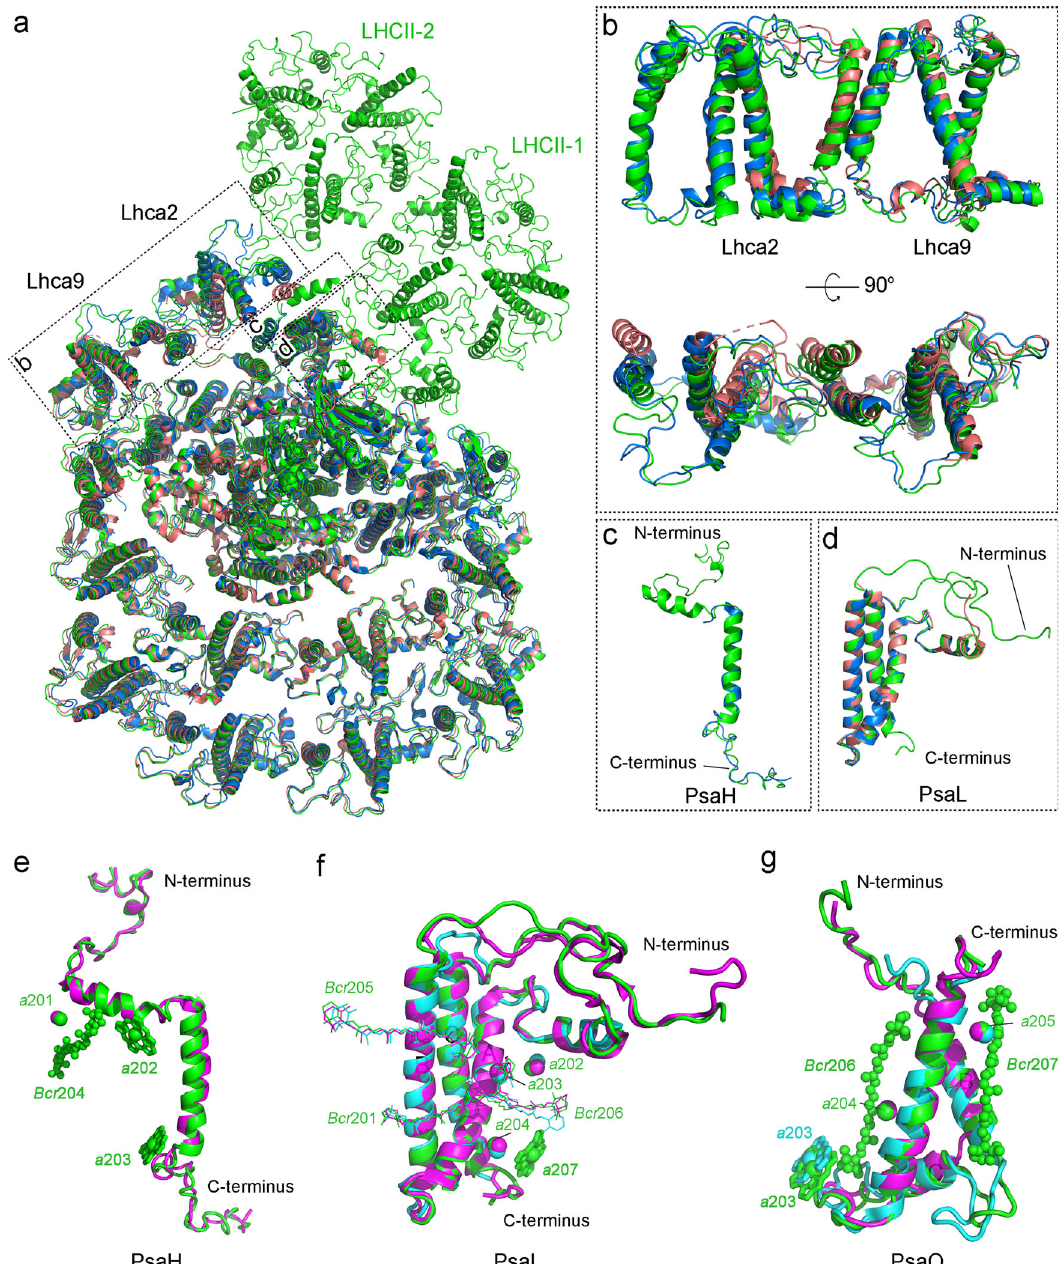
Fig. 4 Structures of the PSI-LHCI moiety and individual subunits in the PSI-LHCI-LHCII supercomplex of C. reinhardtii and their comparisons with those from the PSI-LHCI of red alga, green alga and the PSI-LHCI-LHCII of higher plant. a Structural superposition of Cr-PSI-LHCI-LHCII (green) and two Cr-PSI-LHCI supercomplexes (PDB code 6JO5 and 6IJO, deep-salmon and marine) viewed from the stromal side. b – d Enlarged views of the Lhca2/ Lhca9 subunits ( b ), PsaH subunits ( c ), and PsaL subunits ( d ) in a . e Structural comparison of the PsaH subunits from the PSI-LHCI-LHCII of green alga C. reinhardtii (green) and higher plant maize (PDB code 5ZJI, magenta). f , g Structural comparison of the PsaL subunits ( f ) and PsaO subunits ( g ) from the green alga C. reinhardtii (green), the red alga C. merolae (PDB code 5ZGB, cyan) and higher plant maize (PDB code 5ZJI, magenta). The newly discovered chlorophylls and carotenoids in e , f , and g are shown in bold sticks and spheres,